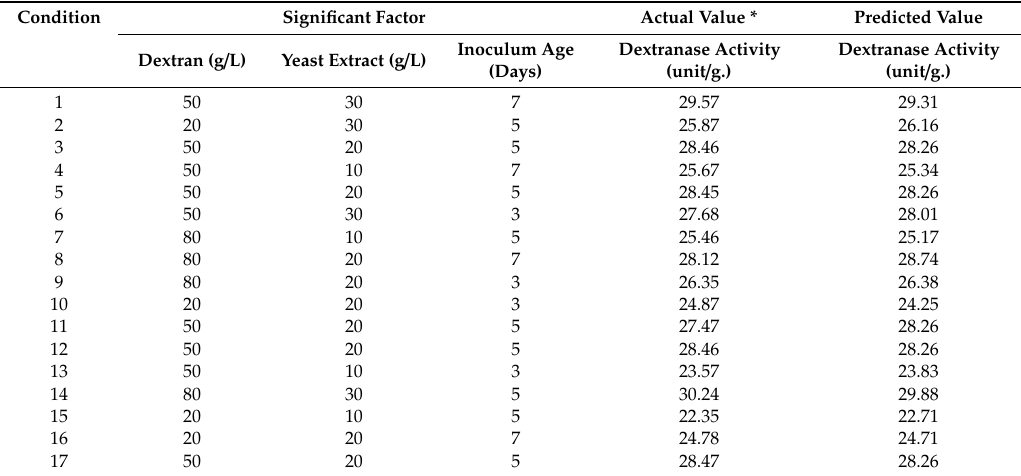
Table 3. Use of Box–Behnken design to investigate the optimization conditions for producing dextranase enzyme (unit / g) from P. roquefortii TISTR